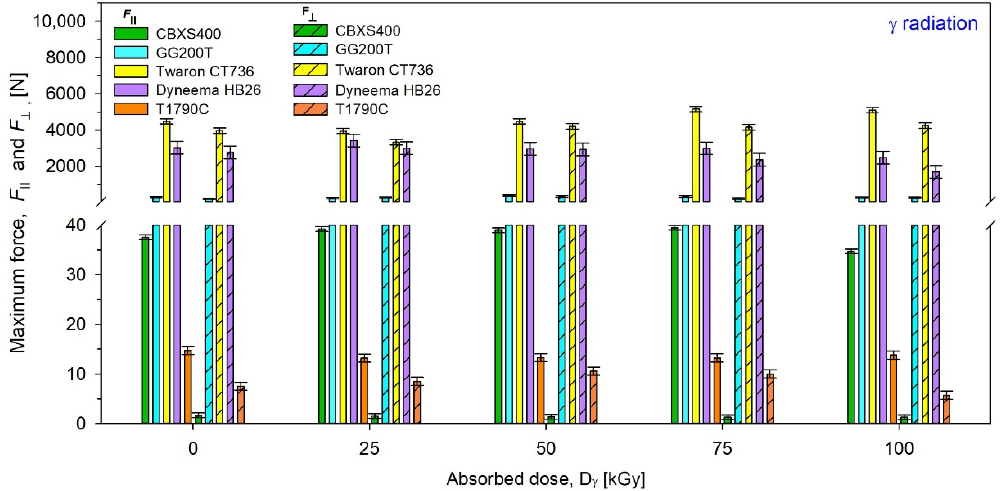
Figure 16. Maximum force of unmodified and γ-irradiated textiles. Results of elongation at maximum force ( L and L II ) of unmodified and modified by